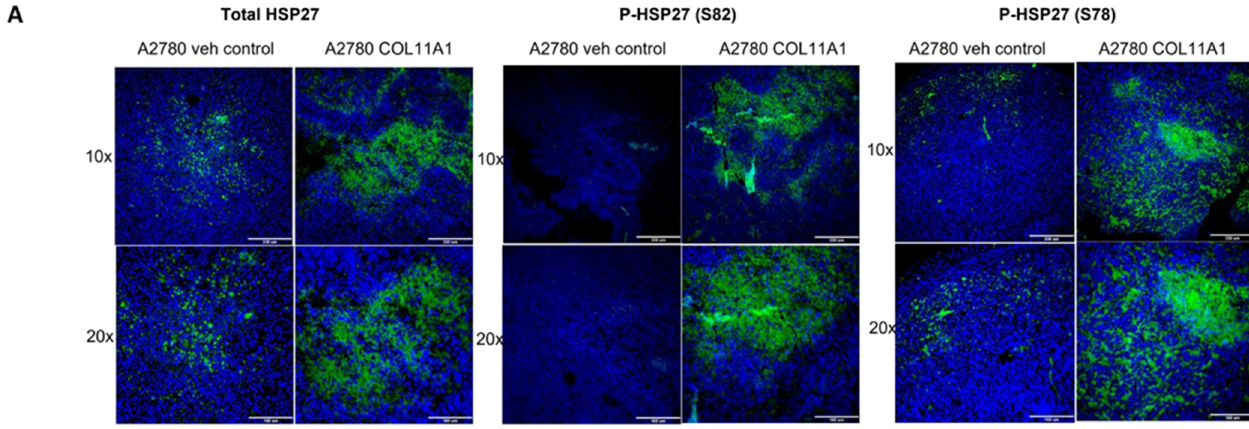
Figure 5. HSP27 expression and phosphorylation is upregulated in vivo in tumor xenografts and in ovarian cancer pa- tients . ( A ) Representative immunofluorescence images of total and p-HSP27 (S78 and 82) in xenograft tumors generated from A2780/vehicle-injected mice and A2780/COL11A1-injected mice. Green: HSP27 (total and phospho); blue: DAPI. Scale bars: 330 µm (10×) and 165 µm (20×). ( B ) Representative images of IHC staining of p-HSP27 (S78) and COL11A1 in A2780CIS-scrm and A2780-shCOL11A1 tumors. Scale bar: 100 µm. ( C ) Overall survival in patients expressing high levels of HSP27 mRNA compared to the low-expressing group (left). Overall survival in patients expressing high mean expres- sion of COL11A1 and HSP27 mRNAs compared to the low-expressing group (right). 3.6. HSP27 Synergizes with Fatty Acid Oxidation to Enhance Cisplatin Resistance A recent study showed that fatty acid oxidation (FAO) compensates for inhibition (with the drug AUY922) of another heat shock protein, HSP90, in prostate cancer cells [37]. We previously reported that FAO is upregulated by COL11A1 to confer cisplatin re- sistance in ovarian cancer cells [8]. After identifying HSP27 as a novel downstream mole- cule of COL11A1 that promotes cisplatin resistance, it was necessary to test whether HSP27 also regulates FAO in ovarian cancer cells. Consistent with our previous report [8], ES2 cells cultured on COL11A1 showed increased expression of CPT1A (Figure 6A), the rate-limiting enzyme of FAO [38]. Interestingly, when these cells were treated with the HSP27 inhibitor ivermectin, they further increased CPT1A expression, indicative of in- creased FAO (Figure 6A). HSP27 knockdown also upregulated FAO in cisplatin-treated A2780CIS cells (Figure 6B). To test the hypothesis that ovarian cancer cells might upregu- late FAO in response to HSP27 inhibition, similar to prostate cancer cells that have been shown to upregulate FAO in response to HSP90 inhibition [37], co-treatment of ivermectin and cisplatin increased the levels of phosphorylated AMP kinase (at its T172 residue), a master regulator of FAO [39], compared to the cisplatin-only treated controls in A2780CIS cells as well as in A2780 and ES2 cells cultured on COL11A1 (Figures 6C,D and S4A). We also observed that co-treatment of ivermectin and cisplatin increased CPT1A expression in A2780CIS cells as well as in A2780 cells cultured on COL11A1 (Figure 6C,D). These results suggest a potential mechanism by which HSP27 inhibition could lead to FAO up- regulation. In addition to these results, a dose-dependent increase in HSP27 (total and